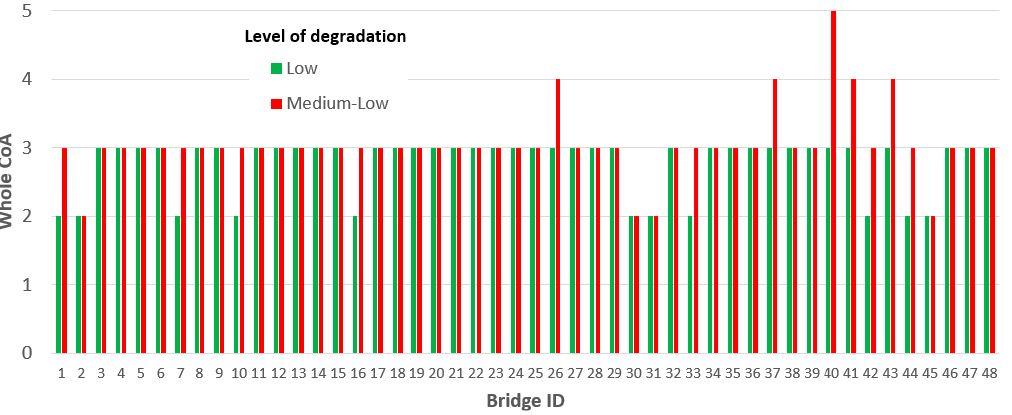
Figure 15. Overall CoA in case of low and medium-low levels of degradation.